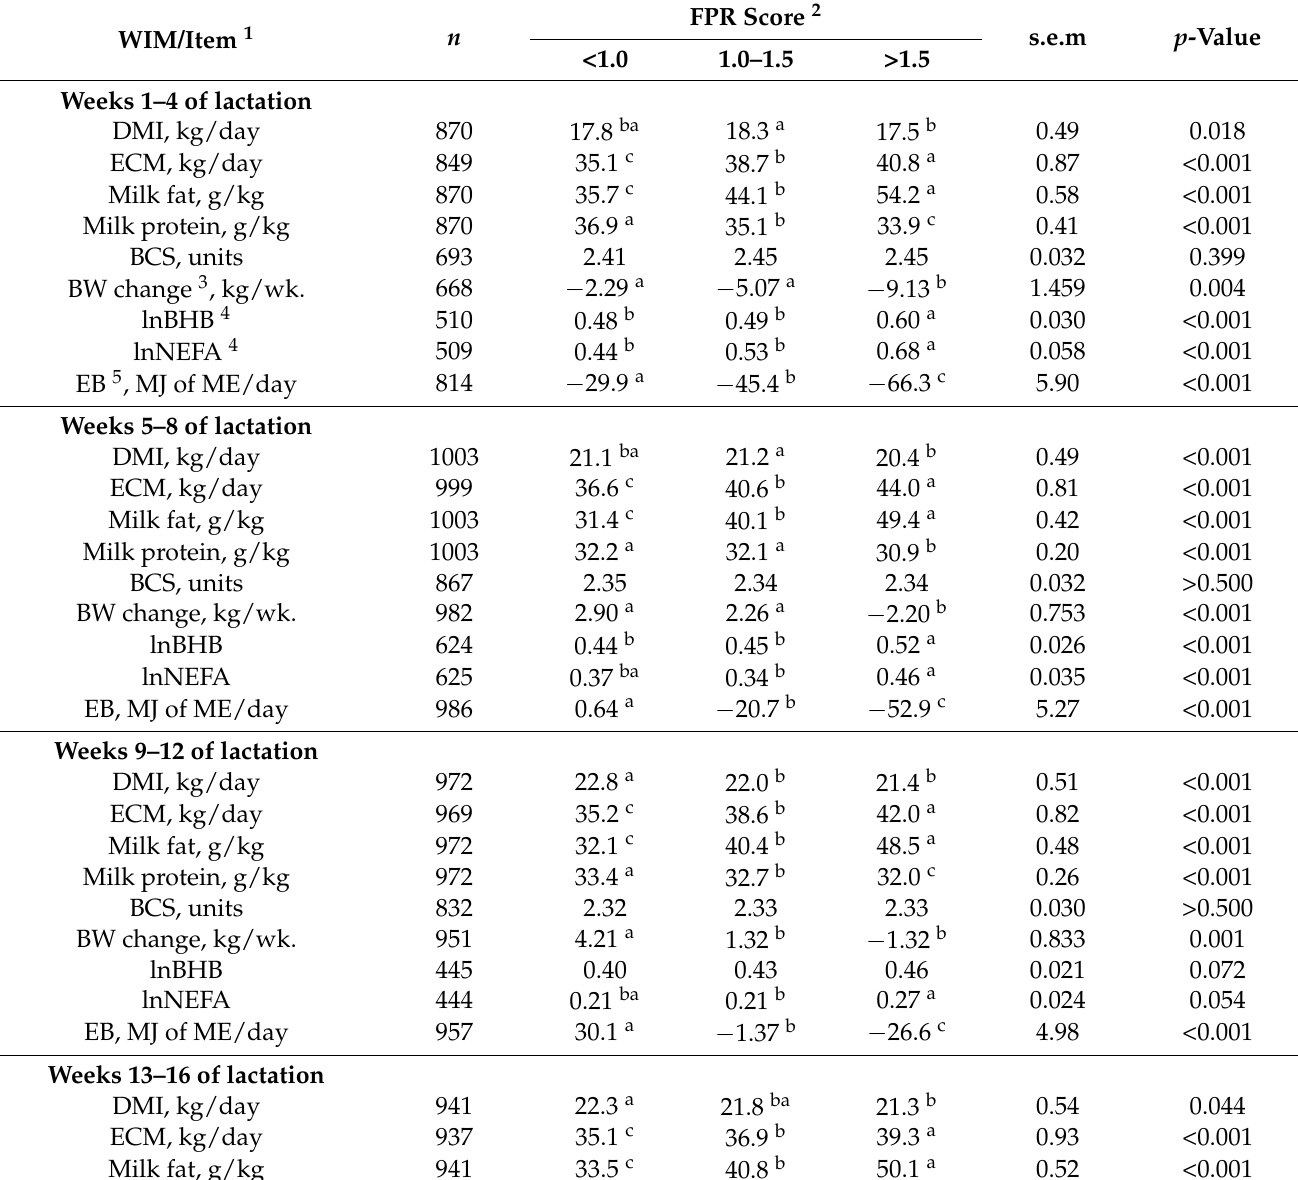
Table 6. Performance indicators and blood metabolites (adjusted least squares means: 4 wk intervals) of third lactation Holstein-Friesian dairy cows within three fat-to-protein ratio scores in milk during early lactation (1–20